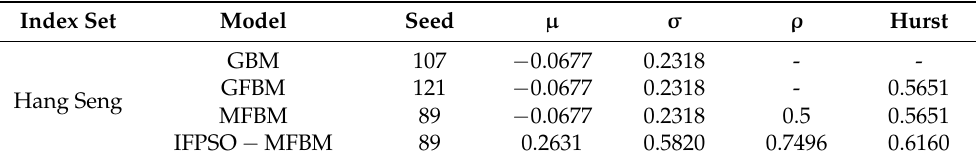
Table 7. Parameters of the Hang Seng in the four models.